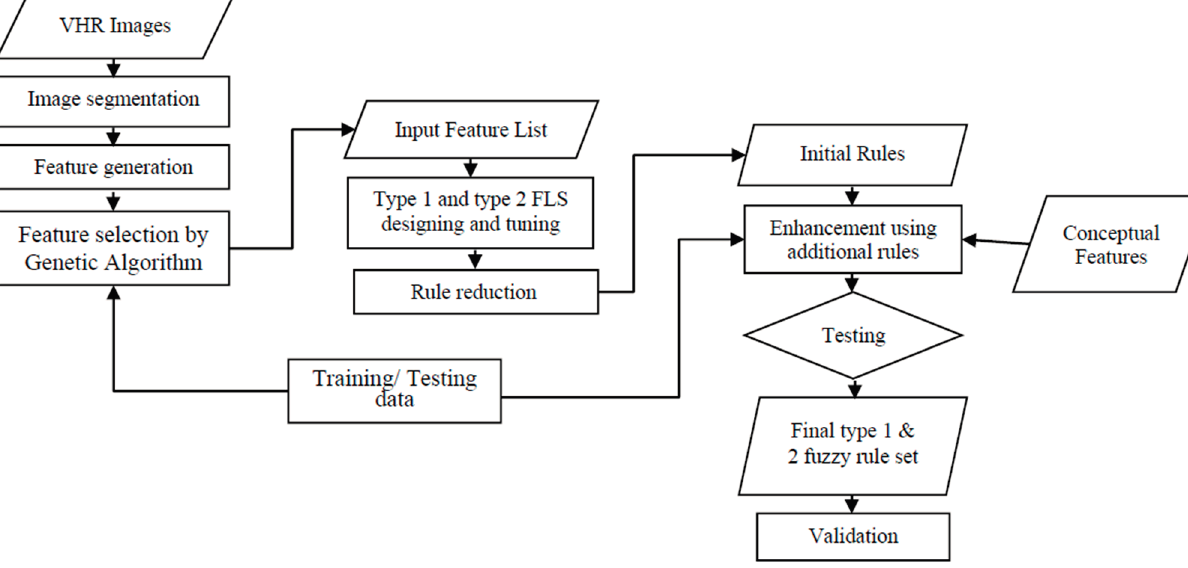
Figure 3. The proposed framework for road